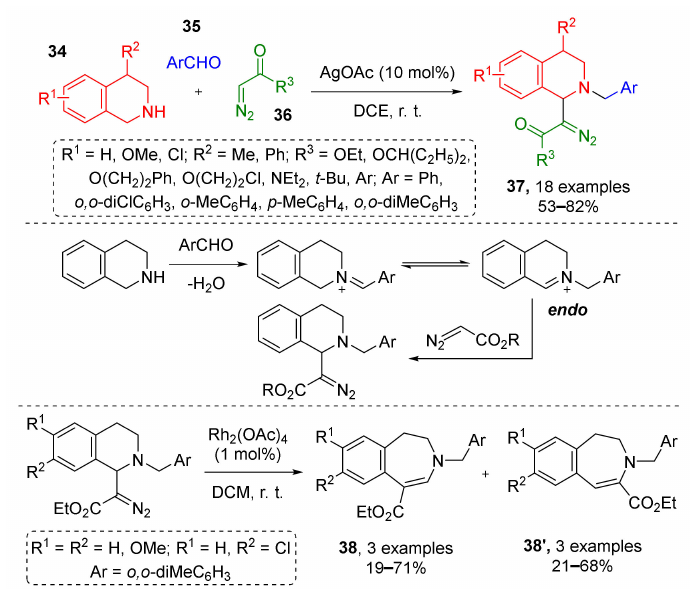
Scheme 10. Functionalization of tetrahydroisoquinolines with diazo carbonyl